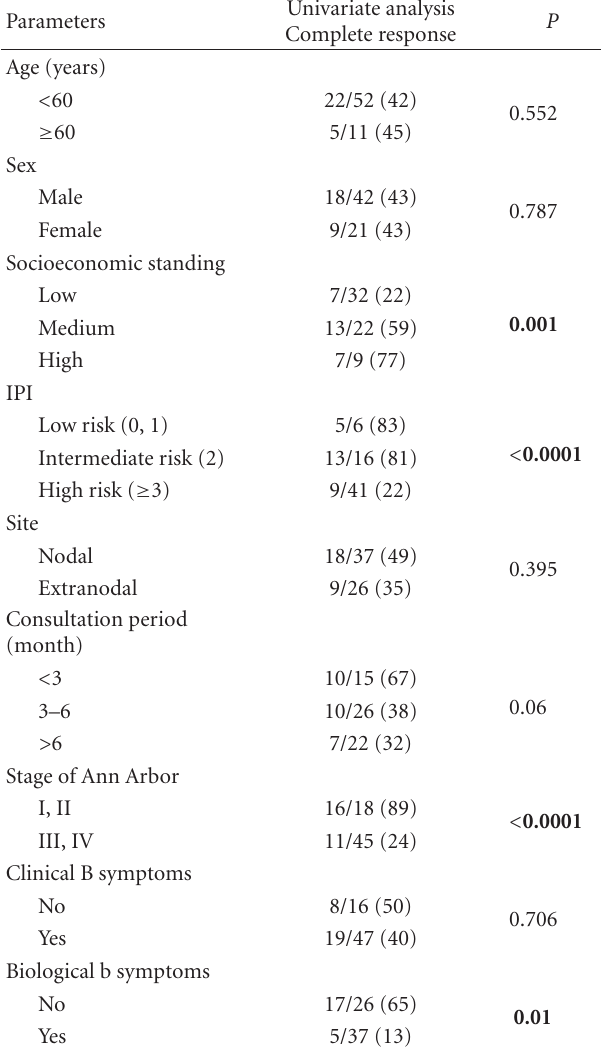
Table 5: Relationship between the therapeutic response and the general characteristics of